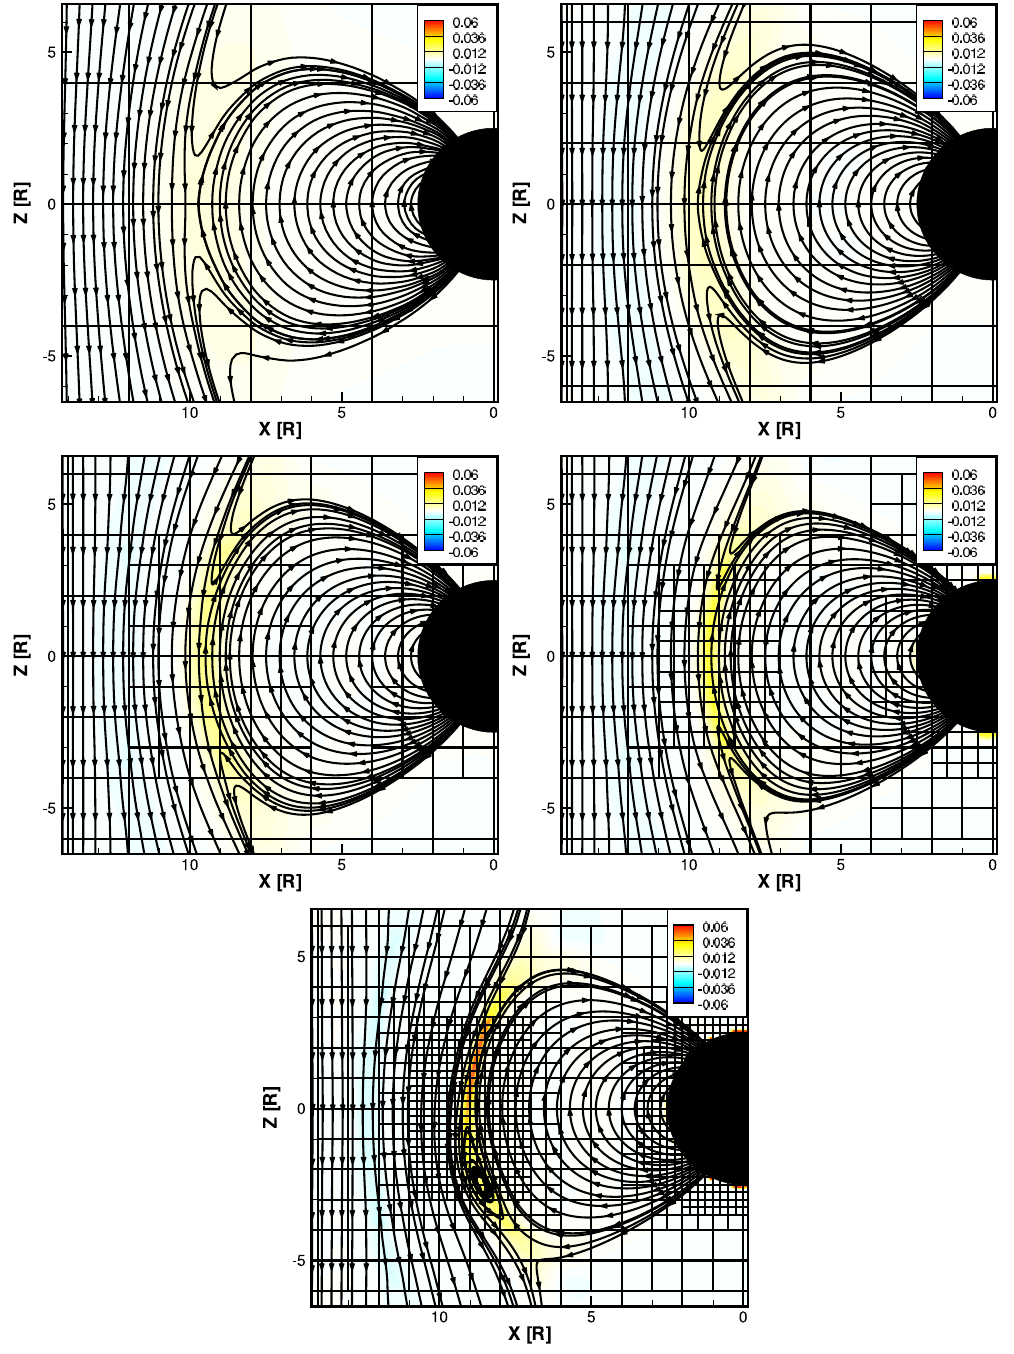
Fig. 10. The current into and out of the plane (i.e., J y in µA/m 2 ) plotted as a color contour plotted under the grid and traces of magnetic field in the Y = 0 plane. The grid is once again shown as the block boundaries, where each square contains 4 × 4 cells. From upper left to bottom right, the highest resolution regions are 1 R E , 1/2 R E , 1/4 R E , 1/8 R E and 1/16 R E . SWMF to describe the magnetospheric configuration at the present time. Table 1 describes the simulations conducted here. Each simulation is a single setting different than another simulation,